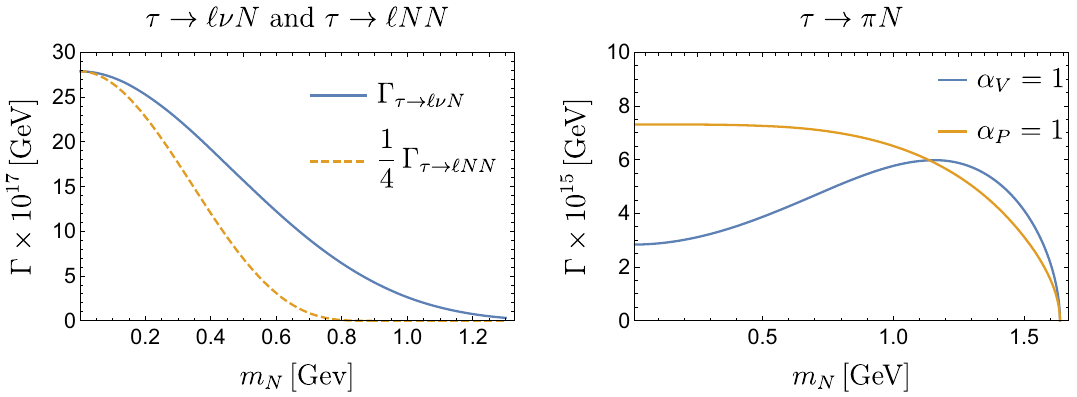
Fig. 6 RH neutrino mass dependence of the τ decay width in different decay channels. Left: decay width of τ → (cid:4)ν N and τ → (cid:4) N N (rescaled) where the mass on the charged leptons has been neglected. Right: decay width of τ → π N for operators with axial and pseudo-scalar